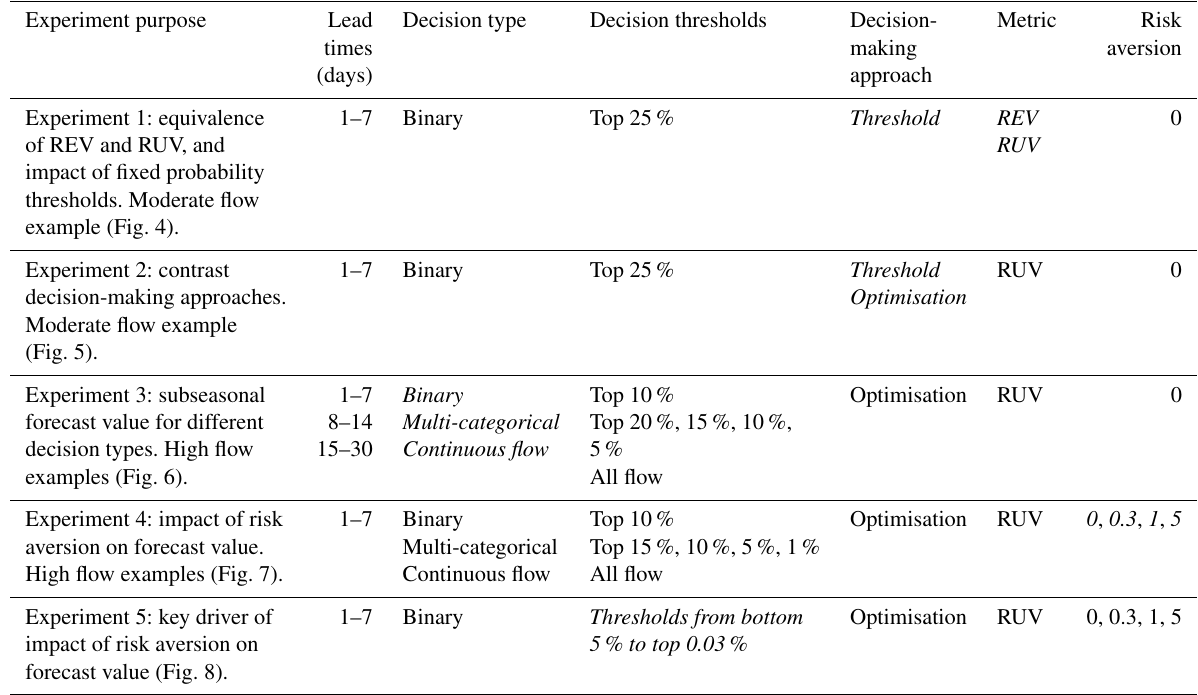
Table 3. Dimensions of forecast value problem used for each figure. The key dimension introduced in each experiment is highlighted with italic